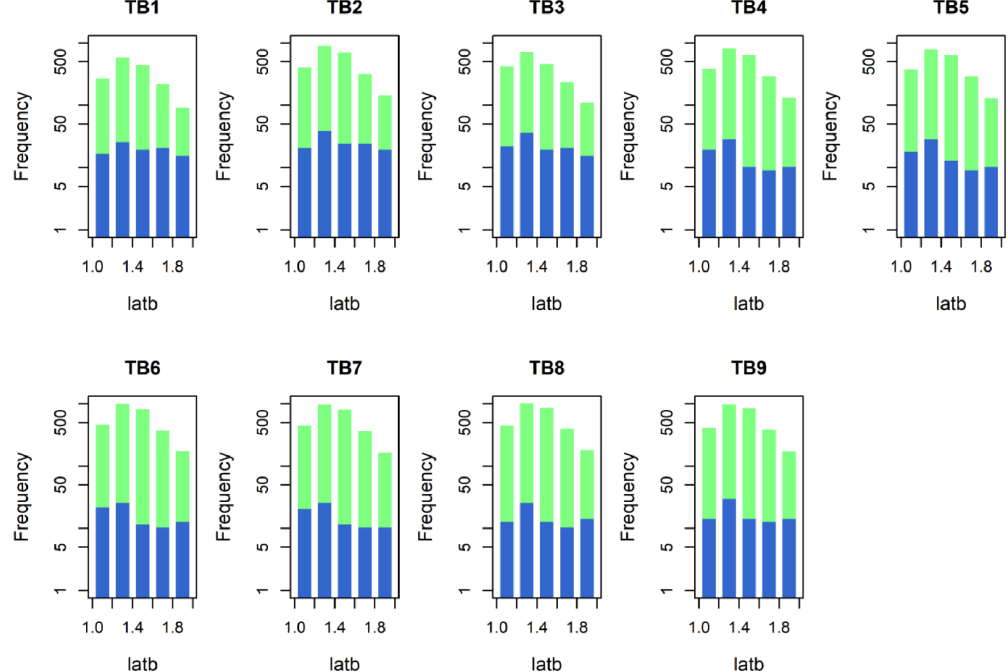
Figure 11. Distribution of good parameter values (parameter latb) for streamflow (in green) and for both streamflow and saturated areas (in blue) with log y axis in nine SWAT-HS setups with different degrees of